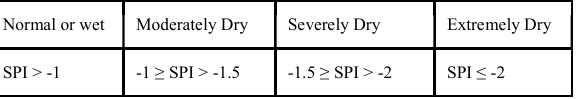
Table 2: Drought categories after SPI and